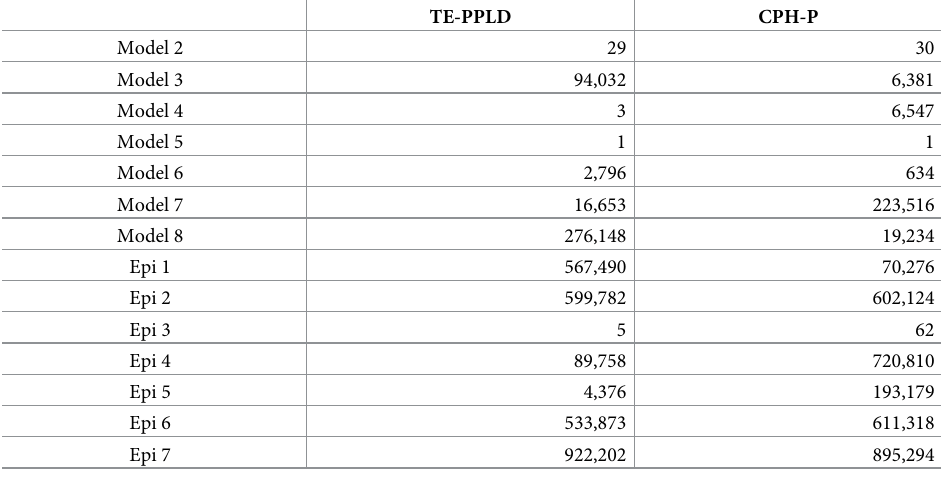
Table 11. Rank order of “true positive” SNPs among all 1,000,014 SNPs.